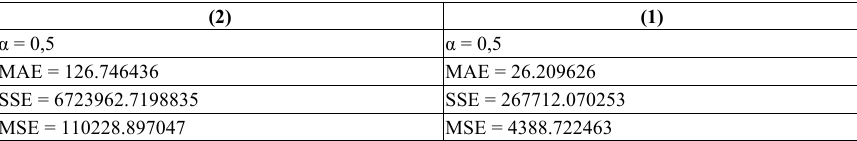
Table 4. Comparison of alpha